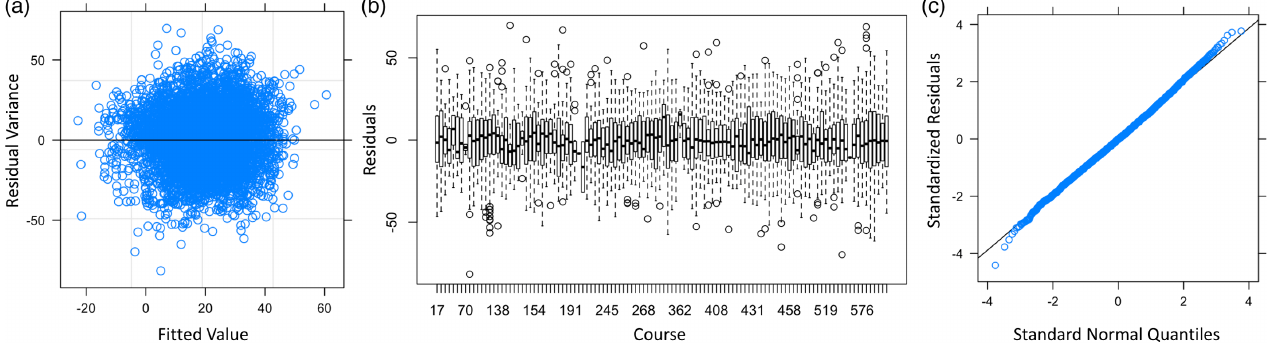
FIG. 3. A visual check of the three assumptions of HLM model 3 from the first MI dataset. (a) Assumption of linearity — A plot of residuals vs fitted values. A random distribution of sample points indicated the model met the assumption of linearity. (b) Assumption of homogeneity of variance — A boxplot of residuals by course. Consistent medians and interquartile ranges indicated the model met the assumption of homogeneity of variance. This assumption was further verified quantitatively using an ANOVA. (c) Assumption of normality — A quantile-quantile plot of the observed and expected values. The points falling close to the line indicated that the model met the assumption of normality.